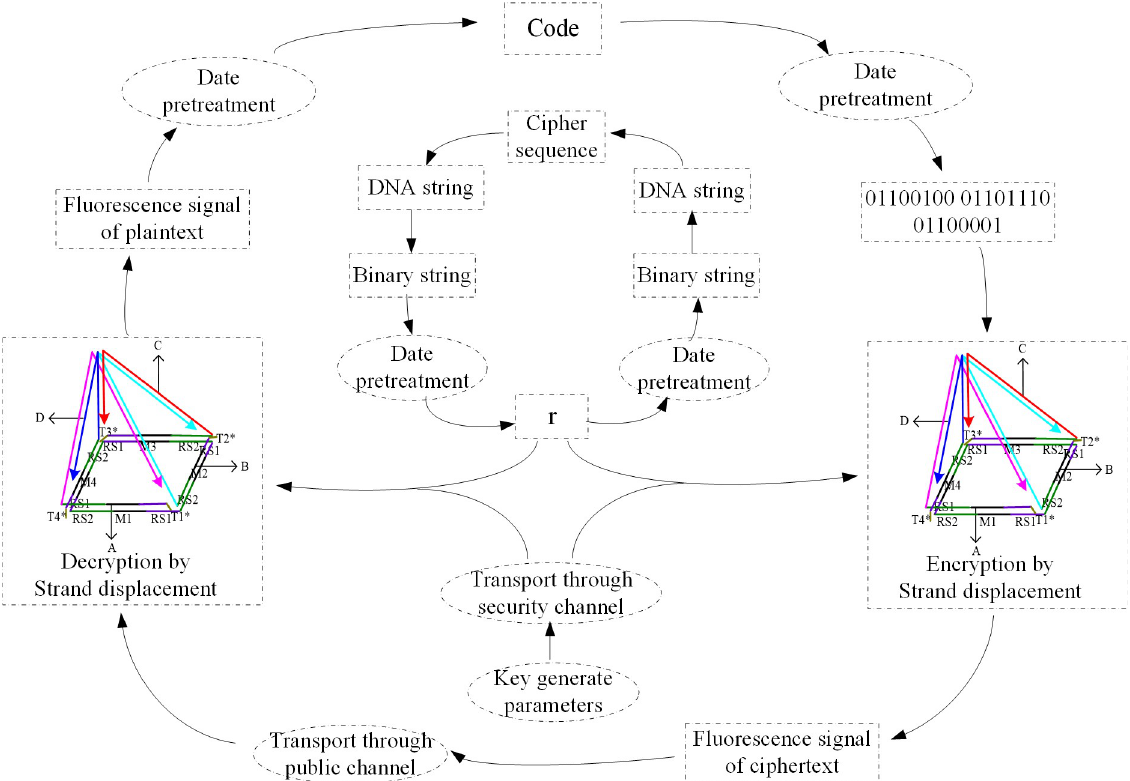
Fig 3. Workflow of DNA cryptography (Encryption process: The plaintext was encrypted with the key after the data processing by using the self-assembly structure; then transmits the fluorescence signal in common channel, and the random numbers were encrypted with steganography and transmitted with the secret information. Decryption process: the decipher first decrypts the random numbers to restructure the self-assembly structure; the key is generated according to the key parameters, then the key and ciphertext are decrypted by XOR operation using the self-assembly structure; the plaintext information is restored after data